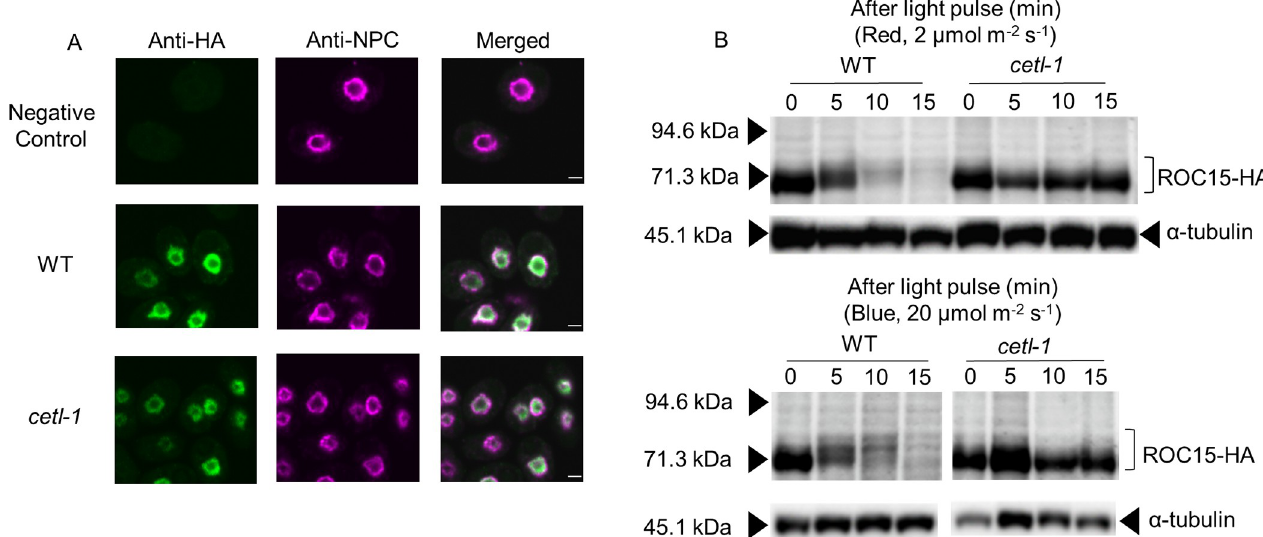
Fig 5. Subcellular localization and phosphorylation of the ROC15 protein in the cetl-1 mutant. The complement ( S4 Fig ) was crossed with the ROC15-HA strain (wild type [WT]) to obtain progenies that inherited ROC15-HA (but not ROC15-LUC ) along with the cetl-1 mutation ( cetl-1 ). Progenies were selected by antibiotic screening and genomic PCRs. A . ROC15 localization in the mutant. Unsynchronized TAP cultures were maintained in darkness for at least 6 hours to allow for accumulation of ROC15-HA. Cells were harvested in darkness and then subjected to immunocytochemistry. The NPC was counterstained as a marker for the nuclear membrane. The BR mt + strain was used as a negative control. Scale bar: 2 μ m. B. Absence of light-induced ROC15 phosphorylation in the mutant. Cells in LD-entrained high-salt cultures were exposed to a 0.5-min light pulse of red (2 μ mol m -2 s -1 ) and blue (20 μ mol m -2 s -1 ) wavelengths at midnight (between ZT14 and ZT17). Western blot analysis was performed on whole protein extracts from cells sampled before the light pulse and at approximately 5, 10, and 15 minutes after the light pulse. The 0 min data corresponds to the sample just before the light pulse. WT in this experiment refers to a wild type sibling from the cross. α –tubulin was used as the loading